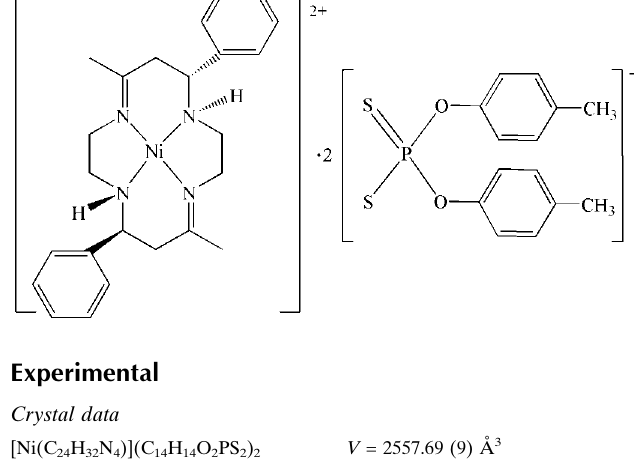
Data collection Oxford Diffraction Xcalibur Eos diffractometer Absorption correction: multi-scan ( CrysAlis PRO RED ; Oxford Diffraction, 2009) T min = 0.930, T max = 1